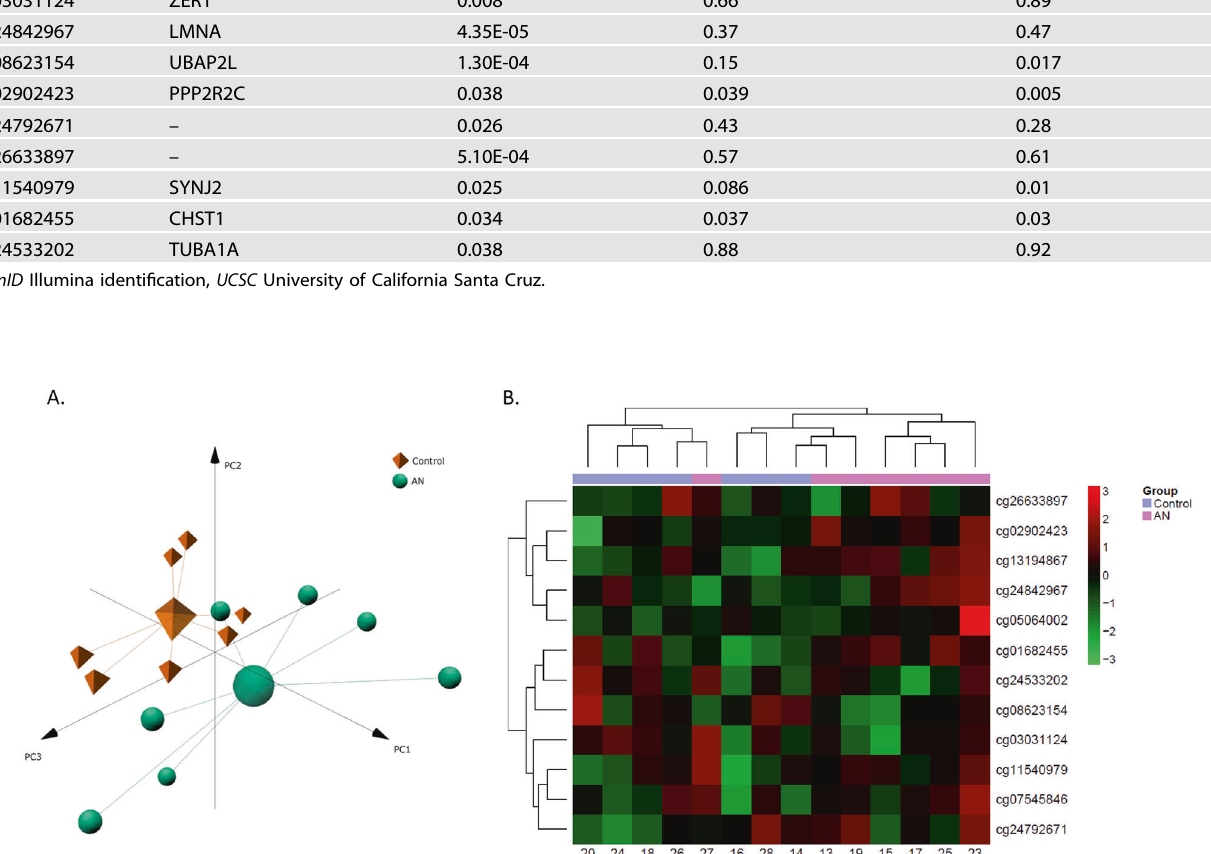
Fig. 4 Validation of the DNA methylation signature in the non-twin validation cohort. A Representation of the Principal Component Analysis (PCA) on the methylation data. Centroids of each group of patients are represented by different shapes and colours. B Heatmap with the methylation status of the differentiating CpGs between AN and control individuals from the non-twin cohort. Rows (CpGs) and columns (individuals) are ordered according to the results of a hierarchical clustering algorithm. Z -score colour scale ranges from green for lower methylation to red for higher methylation levels.